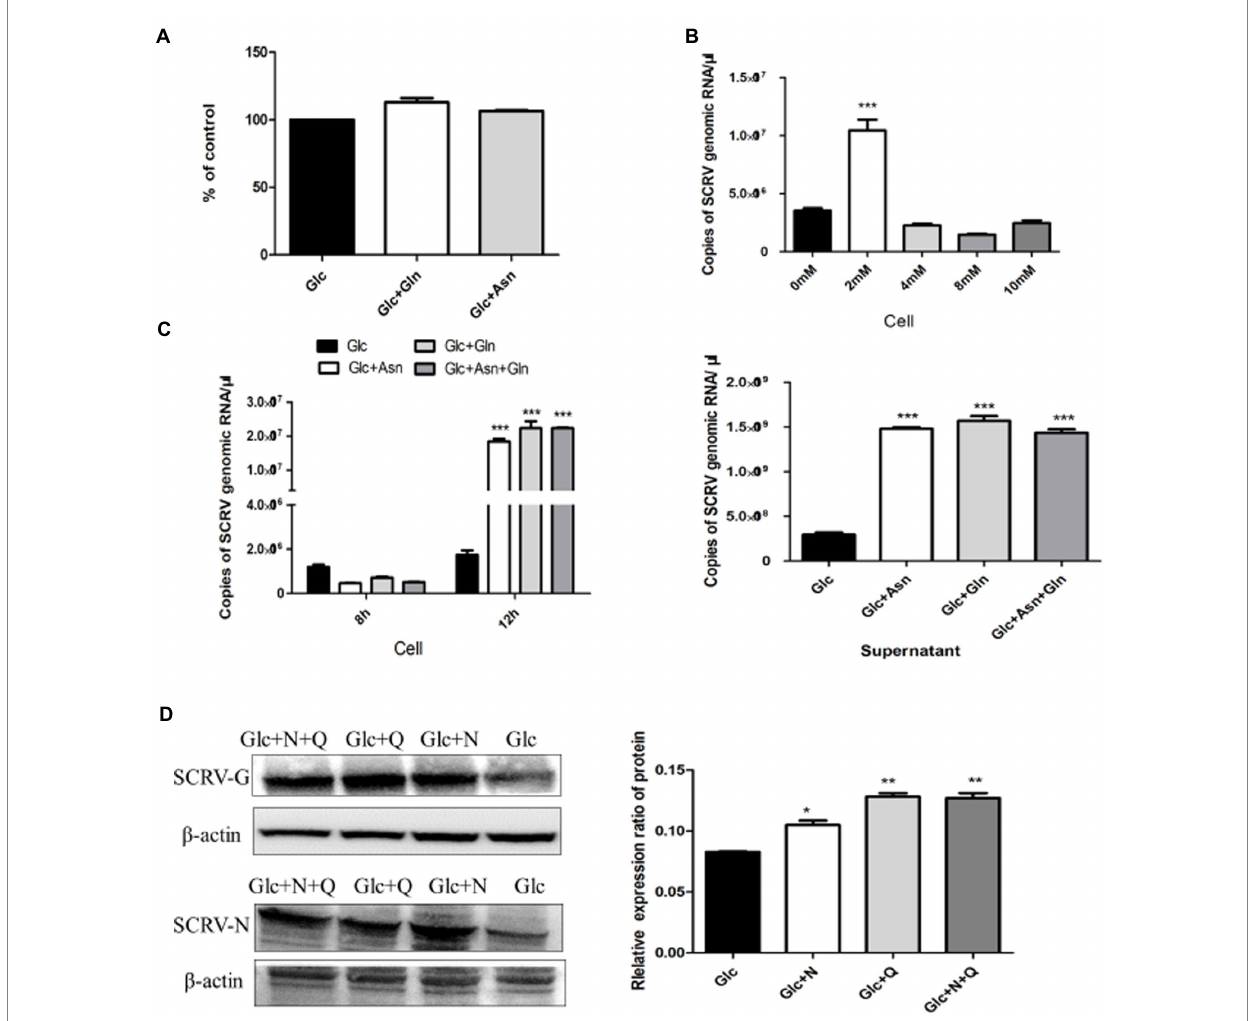
FIGURE 3 Asparagine recused SCRV replication in glutamine depletion. (A) Cell viability of CPB. Cells were fed with medium containing only 1 g/L glucose (Glc), 1 g/L glucose plus 2 mM glutamine (Glc + Gln), and 1 g/L glucose plus 2 mM asparagine (Glc + Asn). At 72 h post treatment, cell viability was measured by CCK8 assay. (B) Optimal rescue concentration of asparagine. The number of virus copies in the medium containing glucose plus 0, 2, 4, 8, and 10 mM asparagine were determined by qPCR, respectively. (C) Comparison of virus production. CPB cells were infected with SCRV at an MOI of 1 and fed media containing 1 g/L glucose (Glc), 1 g/L glucose plus 2 mM asparagine (Glc + Asn), 1 g/L glucose plus 2 mM glutamine (Glc + Gln), and 1 g/L glucose plus 2 mM asparagine plus 2 mM glutamine (Glc + Asn + Gln) at 1 hpi. Intracellular virus was harvested at 8 hpi, and virus in the cells and supernatant was harvested at 12 hpi. (D) Western blot was used to detect and analyze the expression levels of SCRV G and N proteins in SCRV infected cells. CPB cells were infected with SCRV at an MOI of 1 and were given1g/L glucose (Glc), 1 g/L glucose plus 2 mM asparagine (Glc + N), 1 g/L glucose plus 2 mM glutamine (Glc + Q), and 1 g/L glucose plus 2 mM asparagine plus 2 Mm glutamine (Glc + N + Q) media at 1 hpi. Proteins in the cells were harvested at 12 hpi ( n = 3). The control group consisted of glucose only. * p ≤ 0.05, ** p ≤ 0.01, *** p ≤ 0.001. Data are representative of three different independent experiments (mean ±